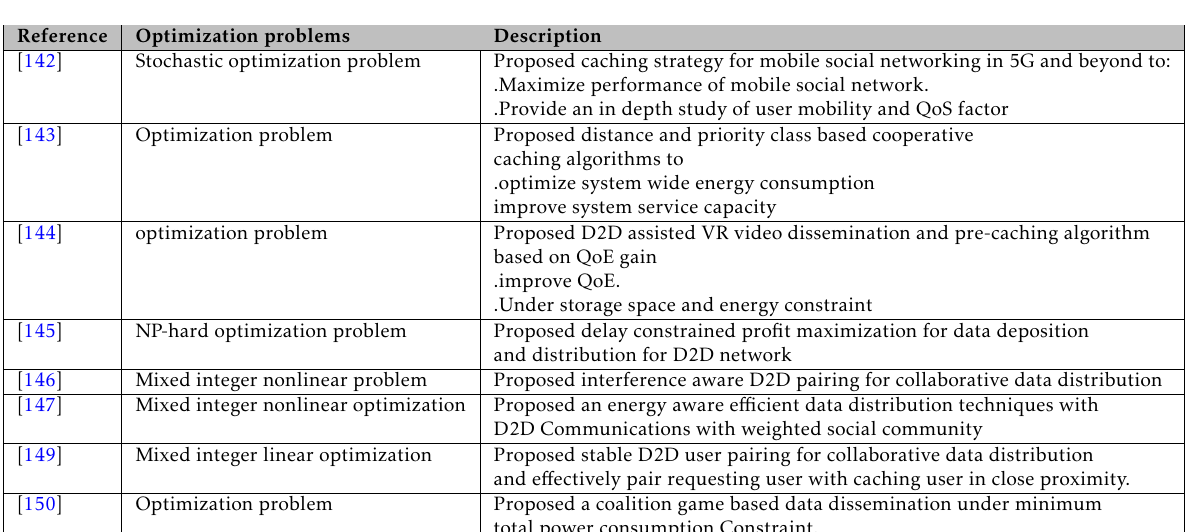
Table 7. Resource Optimization for D2D-based Efficient Data